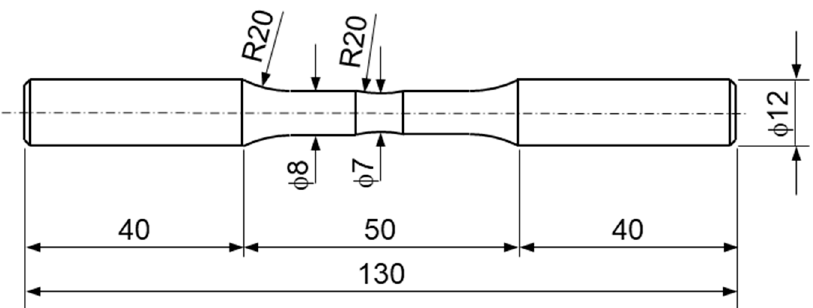
Figure 1. The shape and dimensions of AC4CH samples used for rotating-bending fatigue testing. The dimensions are expressed in millimeters. Table 1. The chemical composition of the AC4CH cast aluminum alloy.